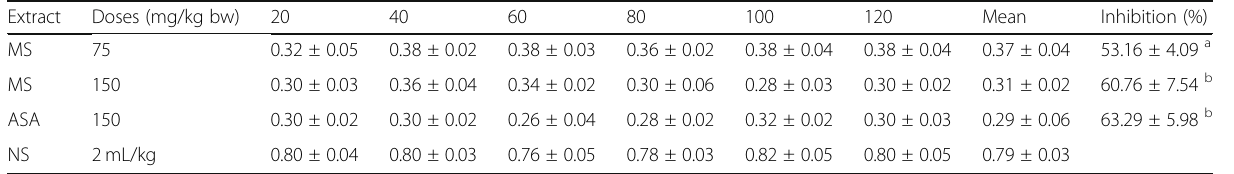
Table 3 Effect of purified fraction of M. senegalensis leaf on oedema Extract Doses (mg/kg bw)